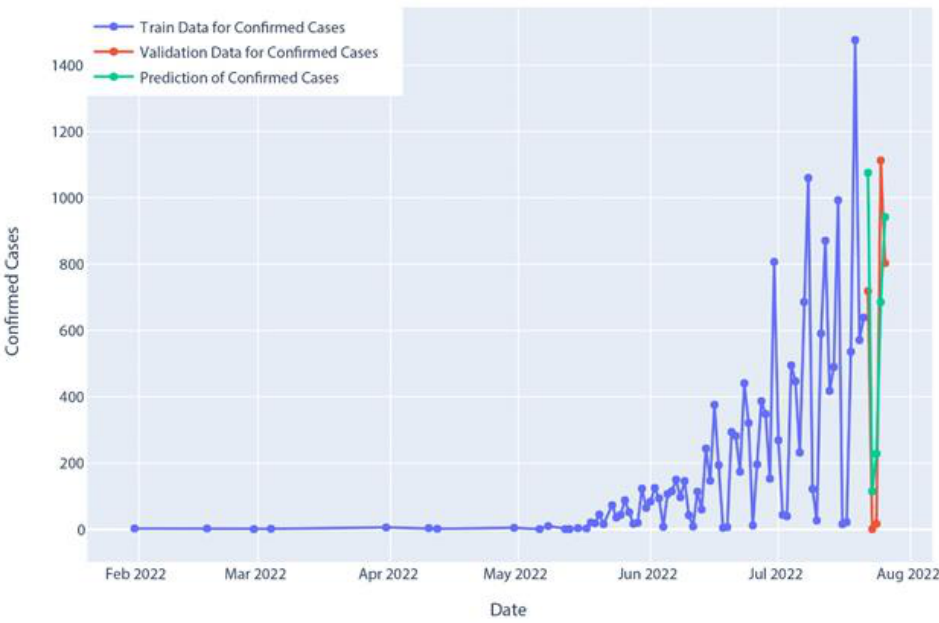
Figure 18. Confirmed cases in Holt–Winter’s model prediction.